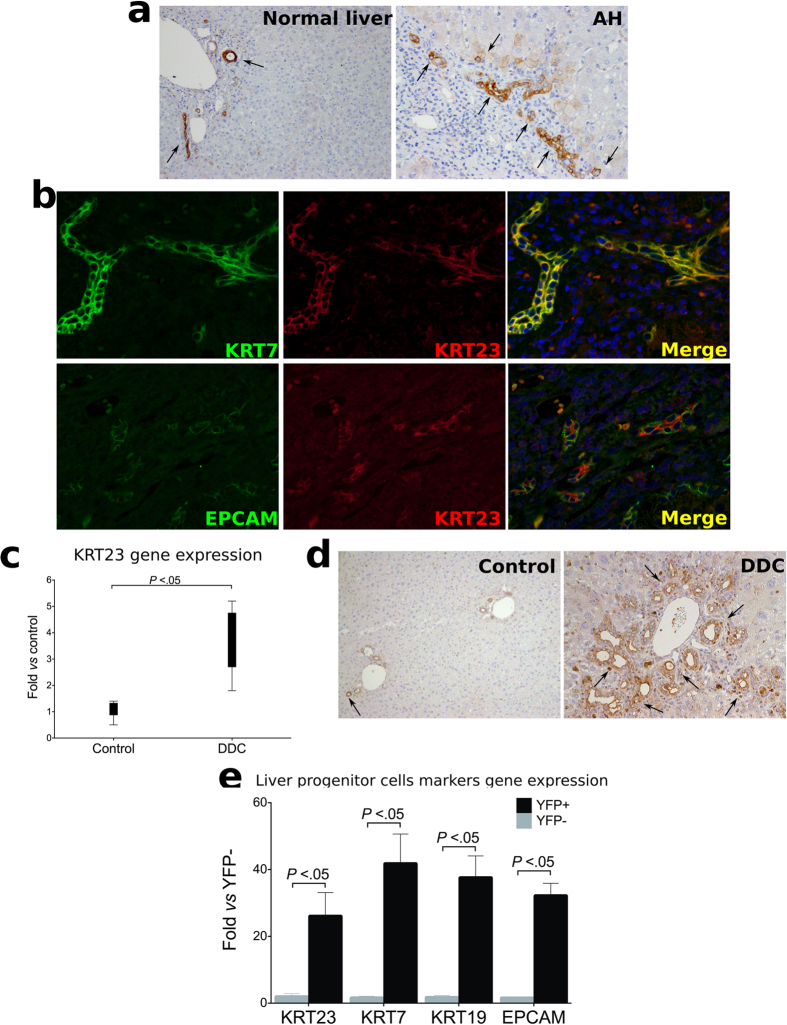
Identification of KRT23 as a Marker of Ductular Cells in AH.(a) Representative micrographs of KRT23 protein expression in paraffin sections of liver biopsies from normal livers and from patients with AH, stained with anti-KRT23 antibody (x100 magnification). (b) Immunofluorescence staining shows co-localization of KRT23 and LPCs markers (KRT7 and EPCAM) in paraffin sections of liver biopsies from patients with AH (x100 magnification). (c) Krt23 hepatic gene expression measured in a mouse model of progenitor cell expansion (DDC diet for 4 weeks, n = 6 compared to uninjured mouse liver (control, n = 6). (d) Representative images of liver KRT23 staining in mice treated for 4 weeks with a DDC diet and in uninjured mice (x200 magnification). (e) Krt23 and LPCs markers (Epcam, Krt7, Krt19) gene expression was significantly enriched in LCP cells (n = 3) vs. a non-LPC population (n = 3).